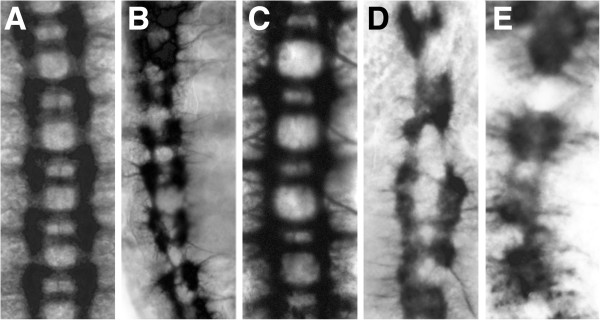
Dominant negative expression in a Dichaete mutant background. A-E) BP102 staining, all embryos oriented with anterior to the top. A) Wild type; B) Dr72/Df(3L)GS1a; C) Dr72/Df(3L)GS1a, simGAL4/UAS-mSox2; D) Dr72/Df(3L)GS1a; simGAL4/UAS-mSox2ΔHMG; E) Dr72/Df(3L)GS1a; simGAL4/UAS-mSox2EnRep
.